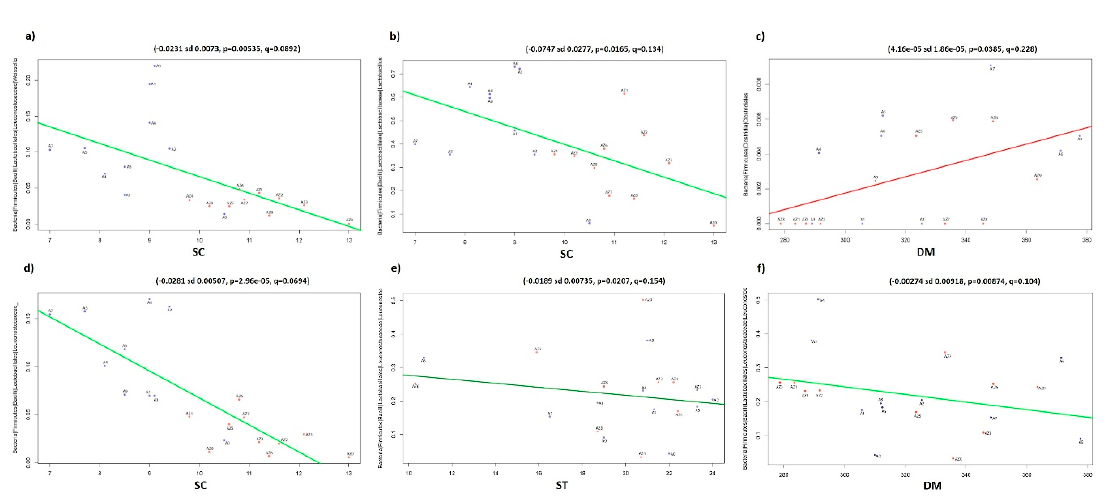
Figure 4. Multivariate linear associations of silages metadata and bacterial relative abundance. Scatter plots show the significant associations of sugar concentration (SC), silage temperature (ST), or dry matter weight of 1 kg of silage (DM) with different Firmicutes: ( a ) Weissella , ( b ) Lactobacillus ( c ) Clostridiales, ( d ) Leuconostocaceae, ( e ) and ( f ) Leuconostoc ; y-axes show the relative abundance of silage bacterial community and x-axes show the silage metadata.